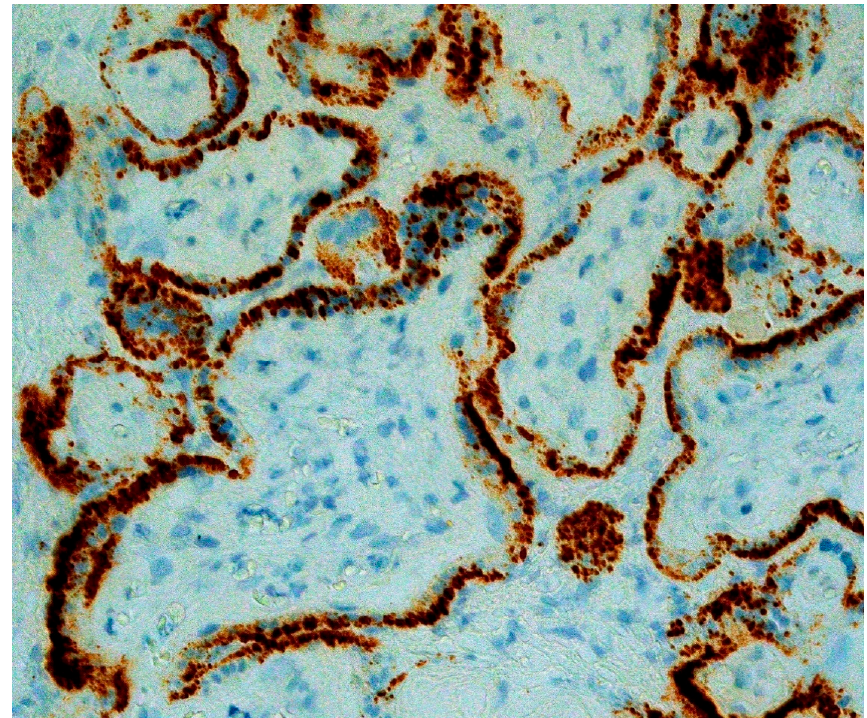
Figure 3. RNAscope for COVID-19 spike protein viral RNA (brown dots) staining positive within the syncytiotrophoblast of multiple chorionic villi. The trophoblast in these villi are intact and have not yet undergone necrosis. There is an intense viral load present. This placenta was described in [23]. ×40 magnification.